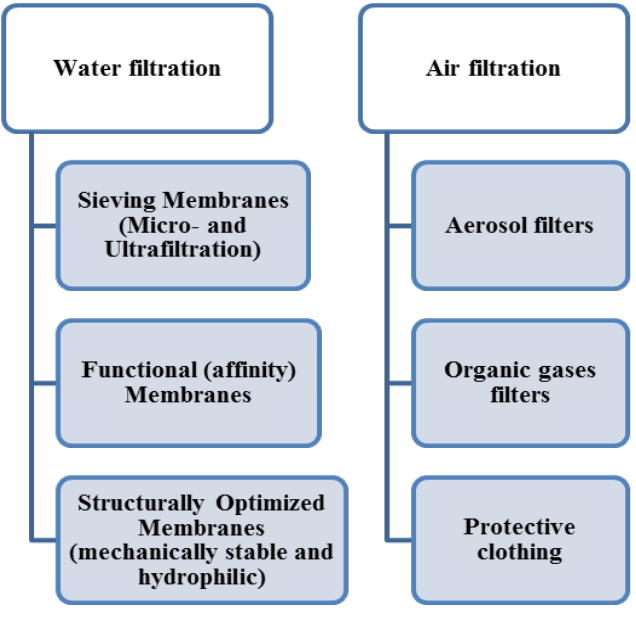
Figure 5. Different classes of nanocomposite/hybrid ENMs based on their environmental applications and